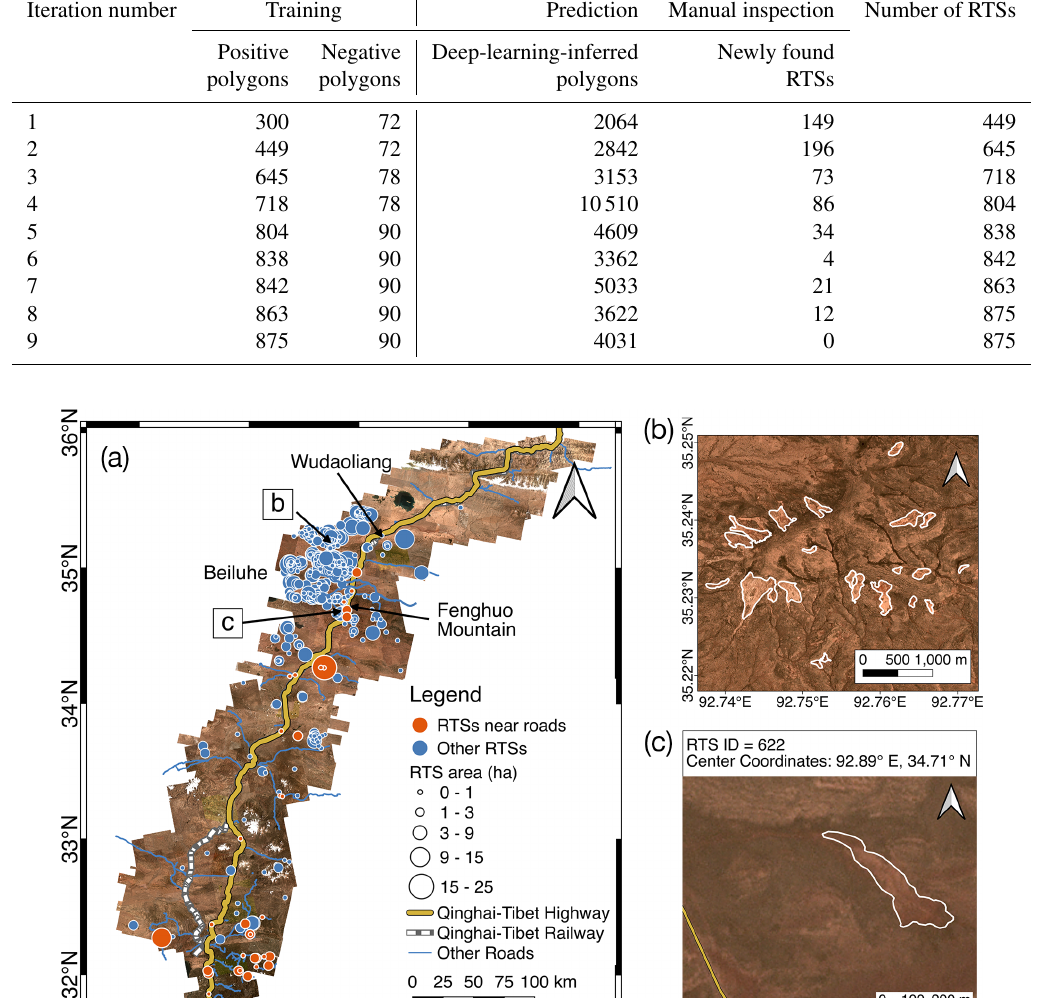
Table 2. Summary of iterative mapping. The positive polygons are RTS boundaries. The negative polygons outline some non-RTS land forms or land cover that appear similar to RTSs in the PlanetScope images. The deep-learning-inferred polygons are the output of the DeepLabv3 + . Newly found RTSs are polygons manually selected from the deep-learning-inferred polygons. We recorded the total number of RTSs for every iteration in the “number of RTSs”.